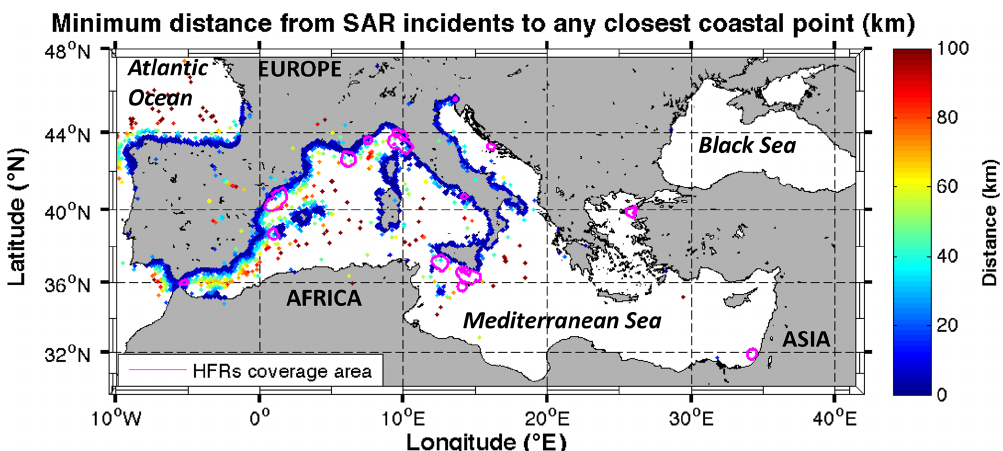
Figure 1. Map of the Mediterranean showing the HFR mean spatial coverage (pink contours) and the location of SAR incidents of France, Italy, Slovenia and Spain from 2019 colored based on their distance to the closest coastal point. For further details about the operational status and the names of the HFR systems the reader is referred to Lorente et al. (2022). In order to indicate the detail of the coverage of the HFRs and their proximity to the incident locations in particular areas, Figs. S1, S2 and S3, available in the Supplement, show zoomed-in views of Italy, the northwestern Mediterranean sub-basin and the Strait of Gibraltar,